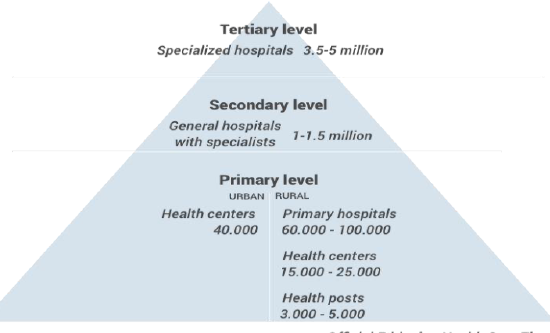
Figure 1. Health Tier System of Ethiopia (Health Sector Development Program IV]